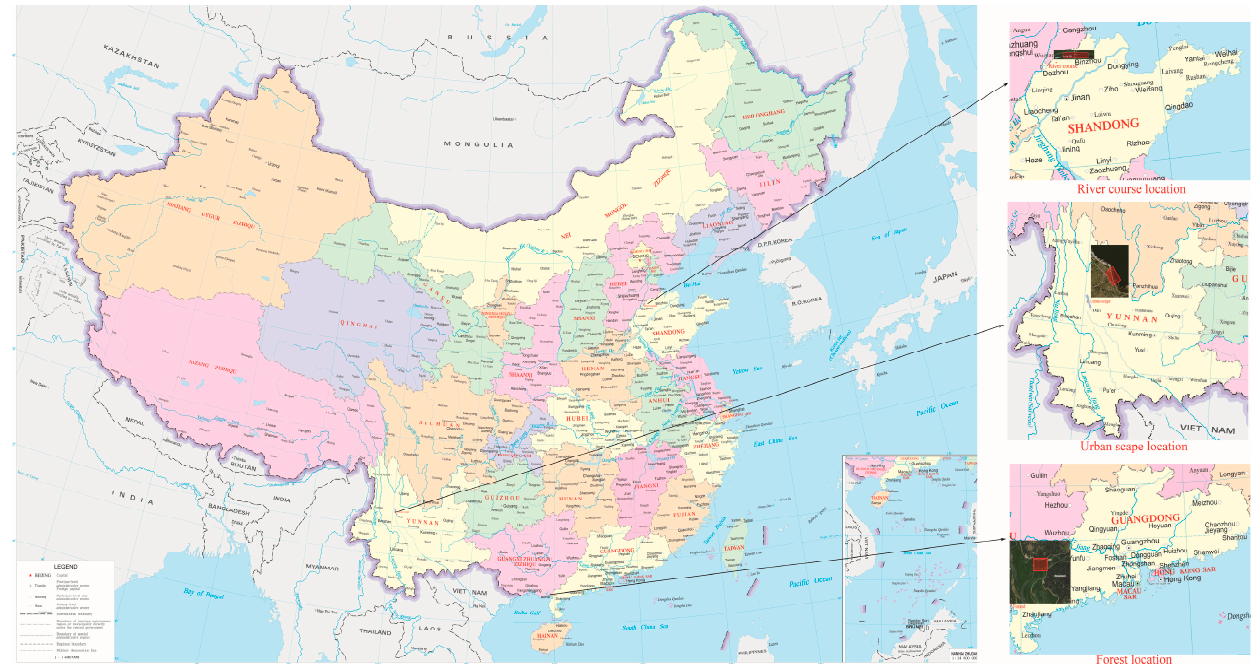
Figure 2. Location of the study areas in China.